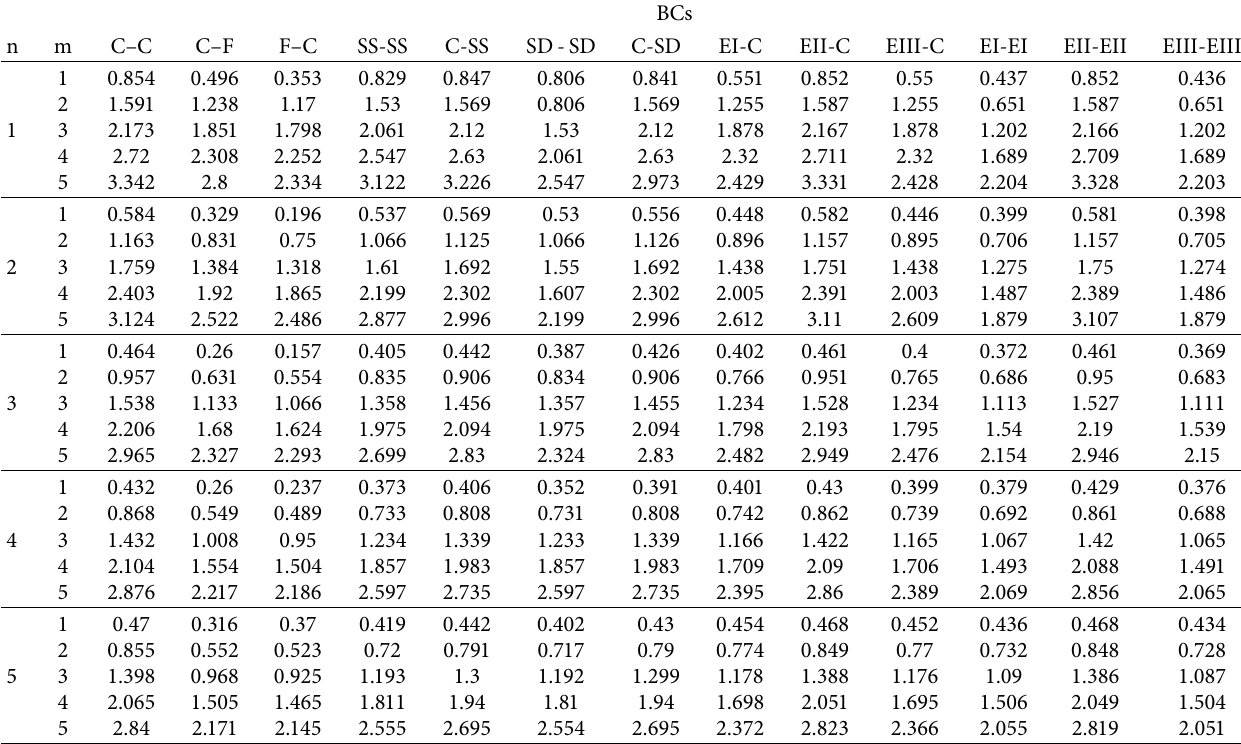
Table 9: The frequency parameters for laminated composite cylindrical shell with variable thickness and different boundary